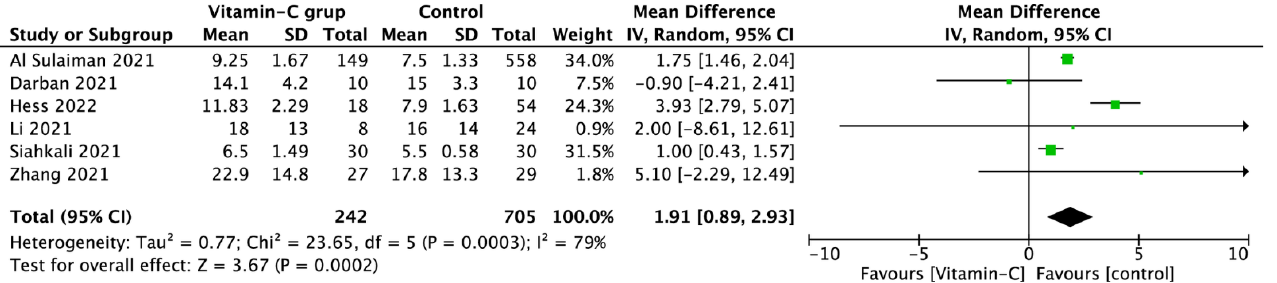
Figure 4. Forest plot of Intensive Care Unit length of stay among COVID-19 patients with and without vitamin C supplementation. The center of each square represents the mean differences for individual trials, and the corresponding horizontal line stands for a 95% confidence interval. The diamonds represent pooled results [32,35,39,41,43,48].